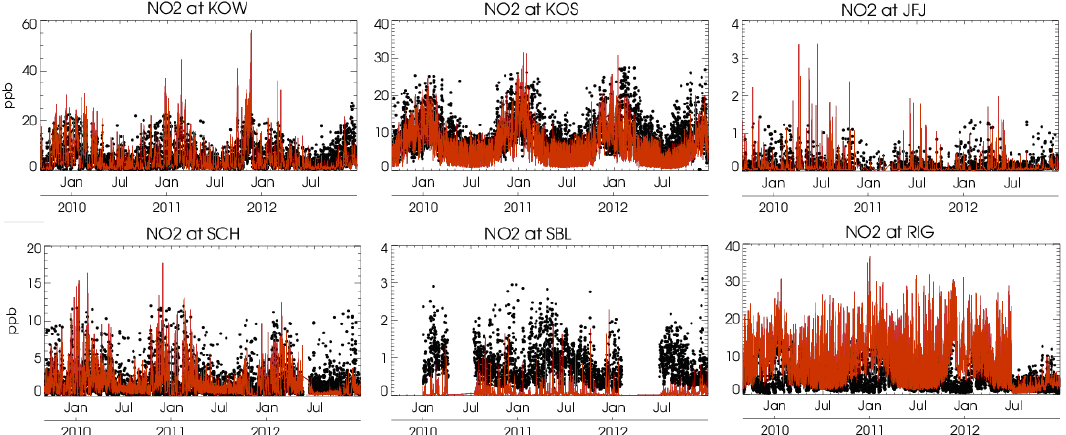
Figure 20. Time series plots of the MACC_osuite 6-hourly NO 2 mixing ratios (red) and GAW surface observations (black) for Kollumer- waard, KOW (Netherlands); Kosetice, KOS (Czech Republic); Jungfraujoch, JFJ (Switzerland); Schauinsland, SCH (Germany); Sonnblick, SBL (Austria) and Rigi, RIG (Switzerland) during the period September 2009 to December 2012. Unit: